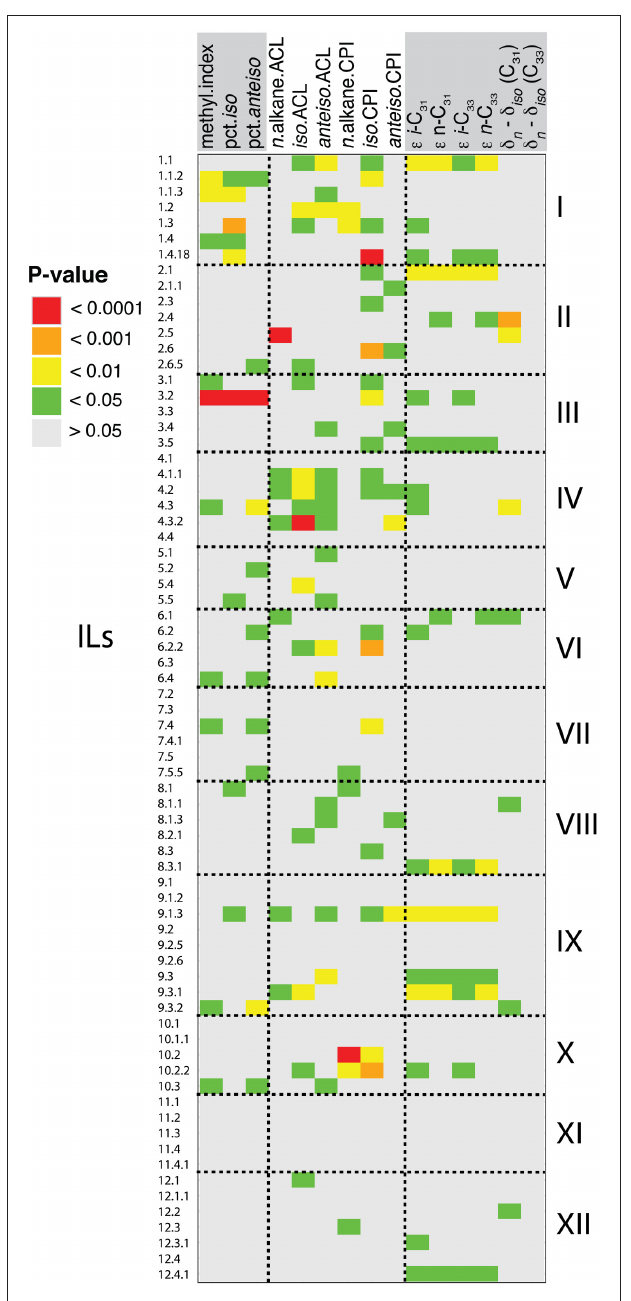
FIGURE 4 | Detected leaf wax QTL. Shown are QTL with p < 0.05, as calculated from mixed-effect linear models for deviation of ILs from cv M82. In total, 139 QTL were detected. Traits are grouped by type: from left to right, methylation traits, structural traits, and carbon isotope traits.